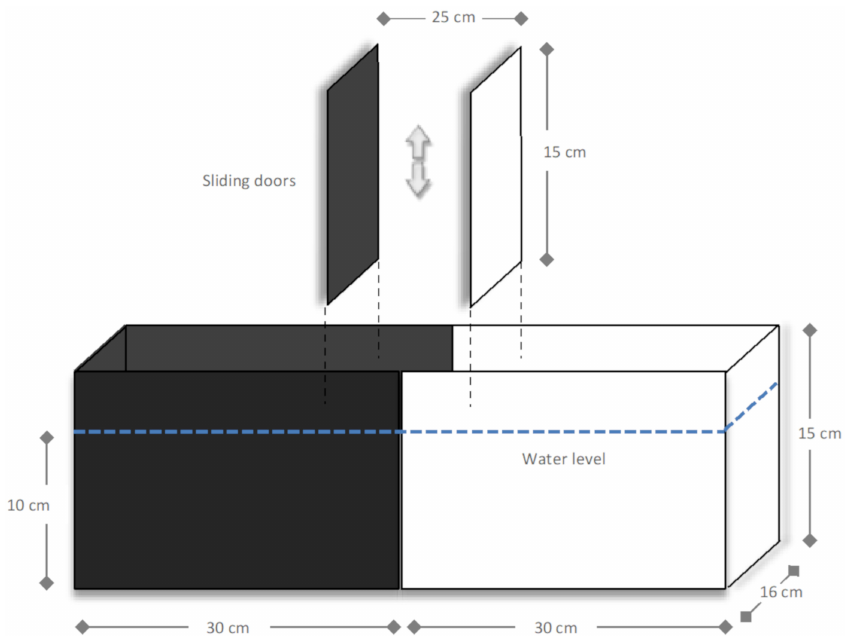
Figure 9. Schematic overview of the dark–light device used for fish behavioural analysis protocol, as adapted from [89]. The apparatus consisted in a non-reflective aquarium made of opaque acrylic of 60 length × 16 width × 15 cm height, with a central compartment of 25 × 16 × 15 cm, and 10 cm water